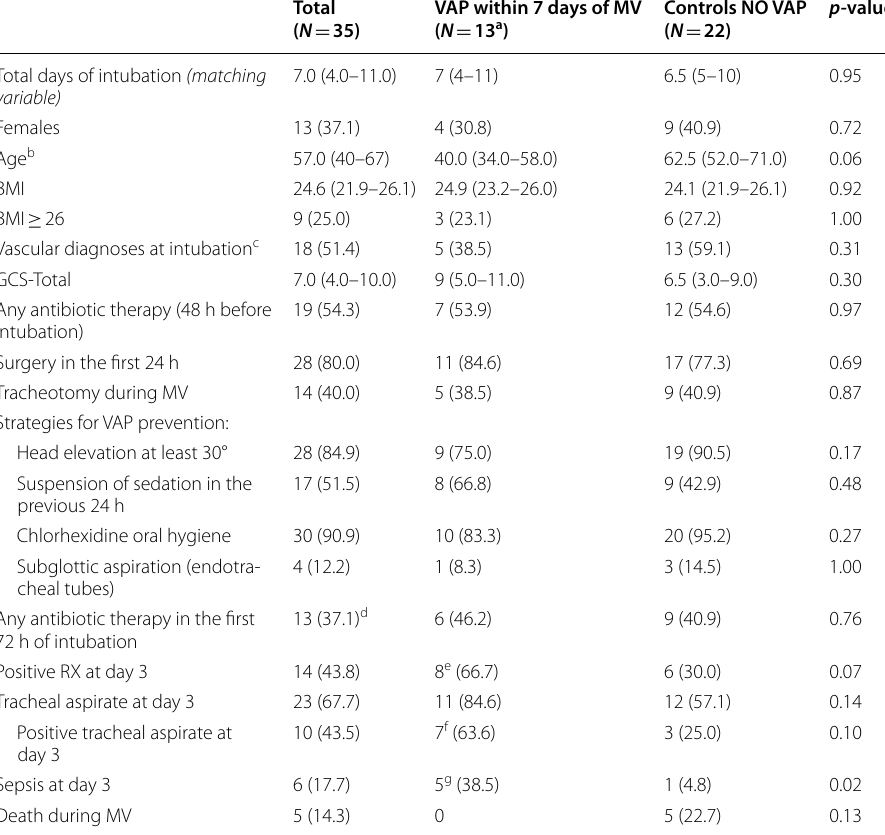
Table 1 Patient’s characteristics and clinical events for VAP and